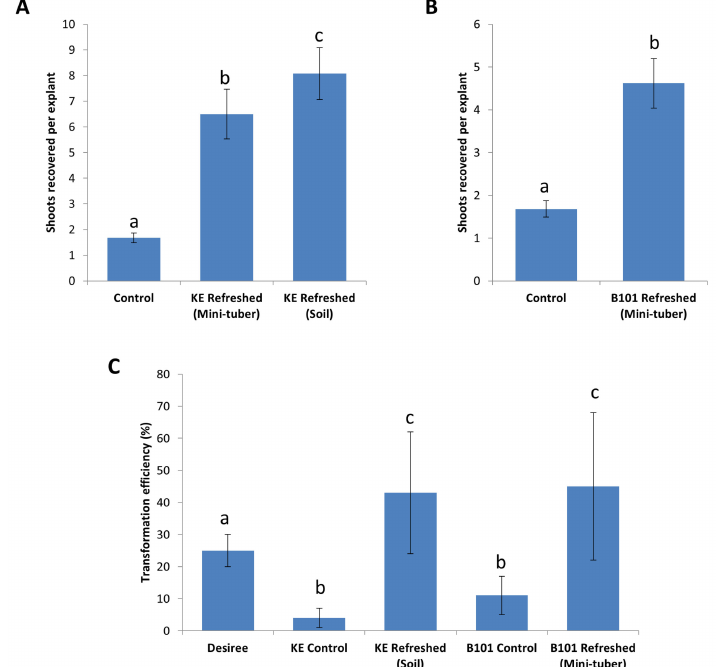
Figure 5. Improvement of shoot induction frequencies by refreshing in vitro stock lines on soil (ex vitro) and via mini-tubers (in-vitro). ( A ) Stock lines of Solanum tuberosum cv. King Edward (KE) refreshed on soil and via mini-tubers showing a higher shoot induction frequencies leading to a higher number of shoots recovered per explant as compared to the control lines. ( B ) Stock lines of diploid B101 refreshed via mini-tubers showing a higher shoot induction frequencies on SIM compared to controls. ( C ) Refreshed lines of both S. tuberosum cv. King Edward (KE) and B101 with higher